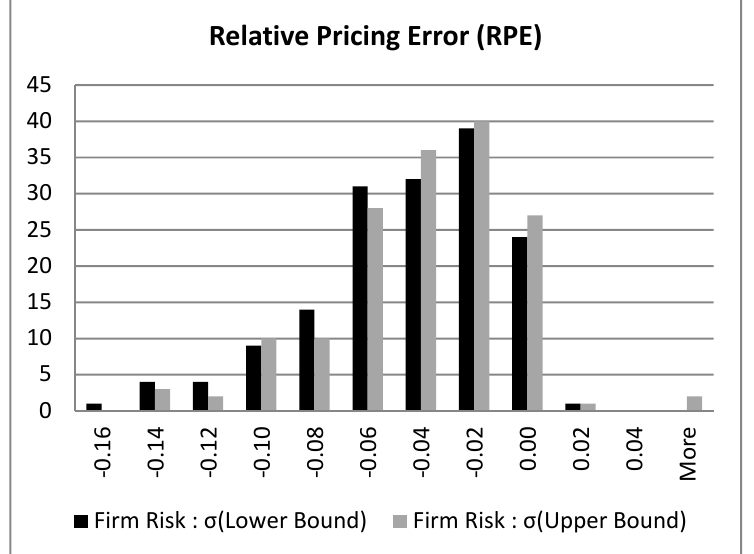
Figure 3. Relative pricing error ( RPE ) at the lower- and upper-bound of the firm’s risk. RPE is calculated as (Offer Price-Model Price)/Model Price . Negative values of RPE indicate that the model overprices the market or that the security is underpriced at issuance. The mean RPE is − 5.56% (stdev. = 3.59%) at the lower-bound of the firm’s risk and − 4.97% (stdev. = 3.77%) at the upper-bound of the firm’s risk.